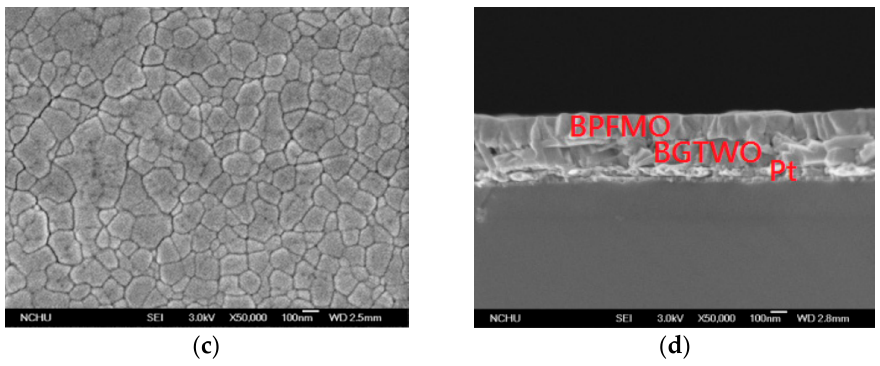
Figure 2. SEM topography image of ( a ) a pure BPFMO thin film; ( b ) a pure BGTWO thin film; ( c ) a BPFMO/BGTWO bilayer thin film; and ( d ) a typical cross section of a BPFMO/BGTWO bilayer thin film.